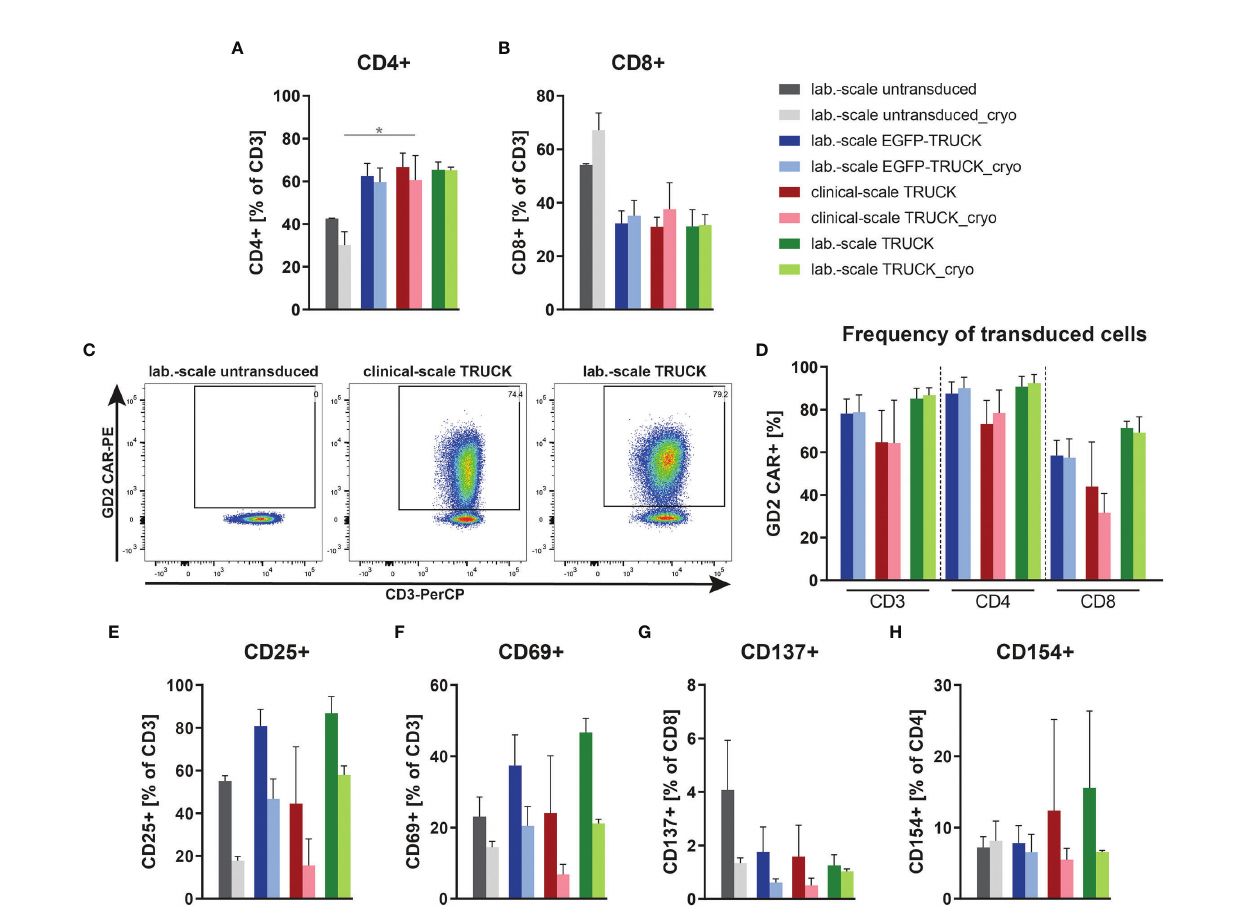
FIGURE 3 | Clinical-scale-manufactured IL-18 TRUCKs targeting GD 2 are transduced and pre-activated at similar ef fi cacies compared to laboratory-scale- manufactured TRUCKs. IL-18 TRUCKs targeting GD 2 were generated using the CliniMACS Prodigy ® (clinical-scale TRUCK; n=2) or under laboratory conditions (lab.-scale TRUCK; n=3). Untransduced T cells (lab.-scale untransduced; n=3) as well as GD 2 TRUCKs with inducible EGFP expression (EGFP-TRUCK; n=3) served as control. The manufactured cells were either characterized directly after the generation process (d12) or after cryopreservation and thawing (cryo). (A, B) Frequency of (A) CD4 + and (B) CD8 + T cells in the fi nal cell product. (C, D) Percentage of CAR + cells of (C) CD3 + cells shown as representative plots and (D) CD3 + , CD4 + and CD8 + cells as assessed by staining of the scFv-domain of TRUCKs with a Ganglidiomab antibody after expansion. (E – H) Expression of the activation markers (E) CD25 on CD3 + , (F) CD69 on CD3 + , (G) CD137 on CD8 + and (H) CD154 on CD4 + T cells. (A, B, D – H) Data are shown as mean ± SD. Statistical differences of large-scale TRUCKs directly after generation or cryopreservation as well as in comparison to laboratory-scale manufactured cells were assessed by Kruskal-Wallis and Dunn ’ s test, signi fi cant differences are shown (*p ≤